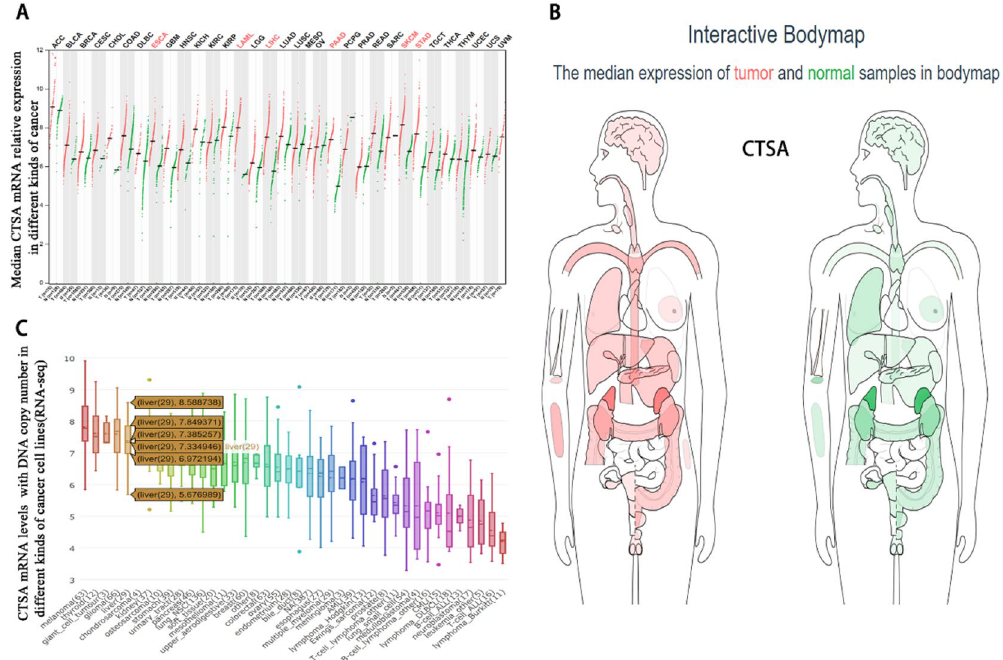
Figure 1. The mRNA expression level of CTSA distributed in different cancer tissues and in bodymap. ( A ) The CTSA expression profile across various kinds of tumor samples and paired normal tissues. Each dots represent the expression of tumor (red) and normal tissue (green). ( B ) The median CTSA expression of tumor (red) and normal samples (green) in bodymap in the GEPIA. ( C ) The CTSA mRNA levels with DNA copy number expressed in different kinds of cancer cell lines using the Cancer Cell Line Encyclopedia (CCLE) website. 29 HCC cell lines have variations in CTSA